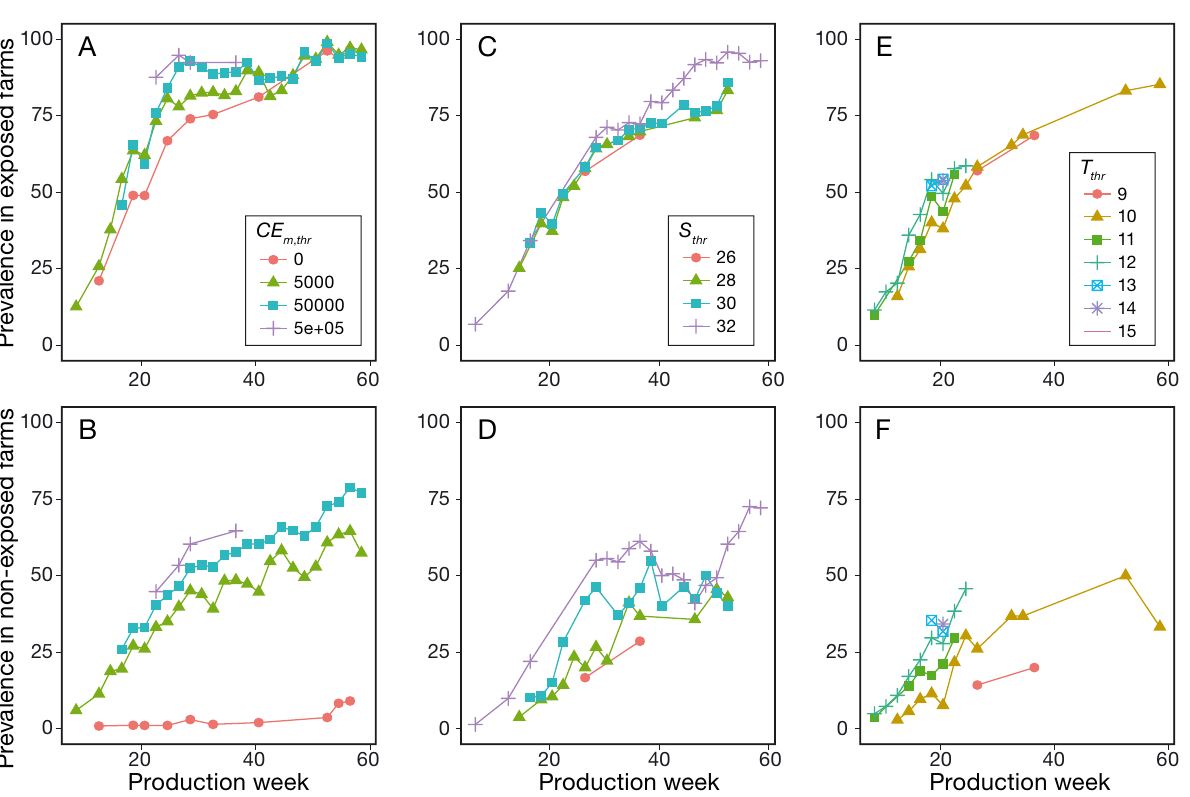
Fig. 6. Observed piscirickettsiosis prevalence at the salmon farms as a function of multiple thresholds in the cumulative exposure to upstream mortality corrected by the strength of (A,B) farm-to-farm hydrodynamic connectivity ( CE m ), (C,D) salinity, and (E,F) temperature. CE m,thr : threshold cumulative exposure to waterborne infection from upstream-infected farms (no. of dead fish × arriving hydrodynamic particles); S thr : salinity threshold (PSU); T thr : temperature threshold